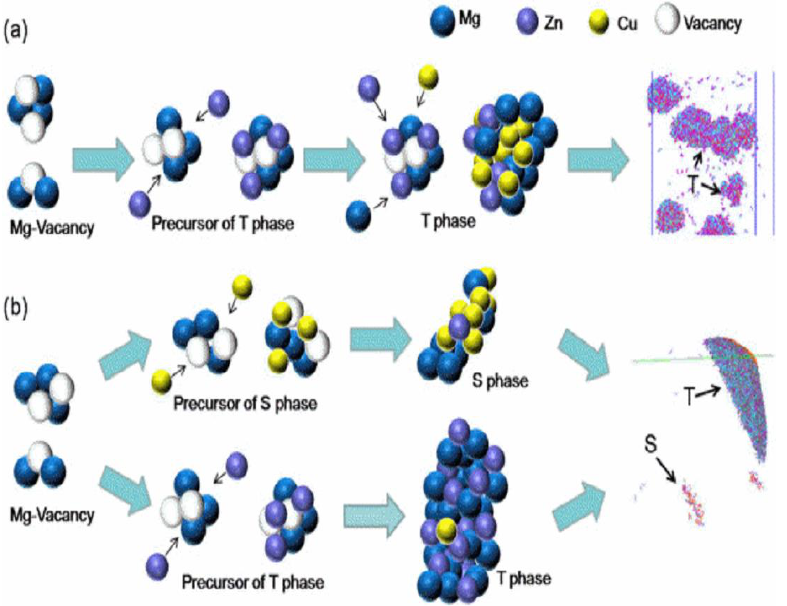
Figure 6. Schematic illustration showing the precipitation behaviors in Al-5.2Mg-2Zn-0.45Cu with ( a ) and without ( b ) pre-aging [8].